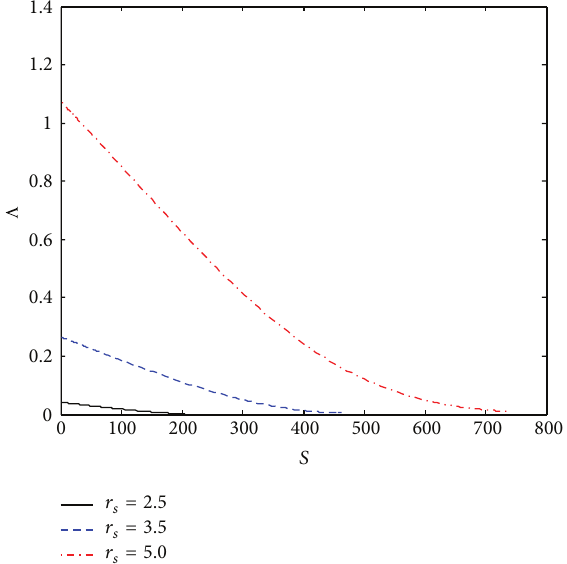
Figure 6: Filtration coefficient as function of captured particle concentration.